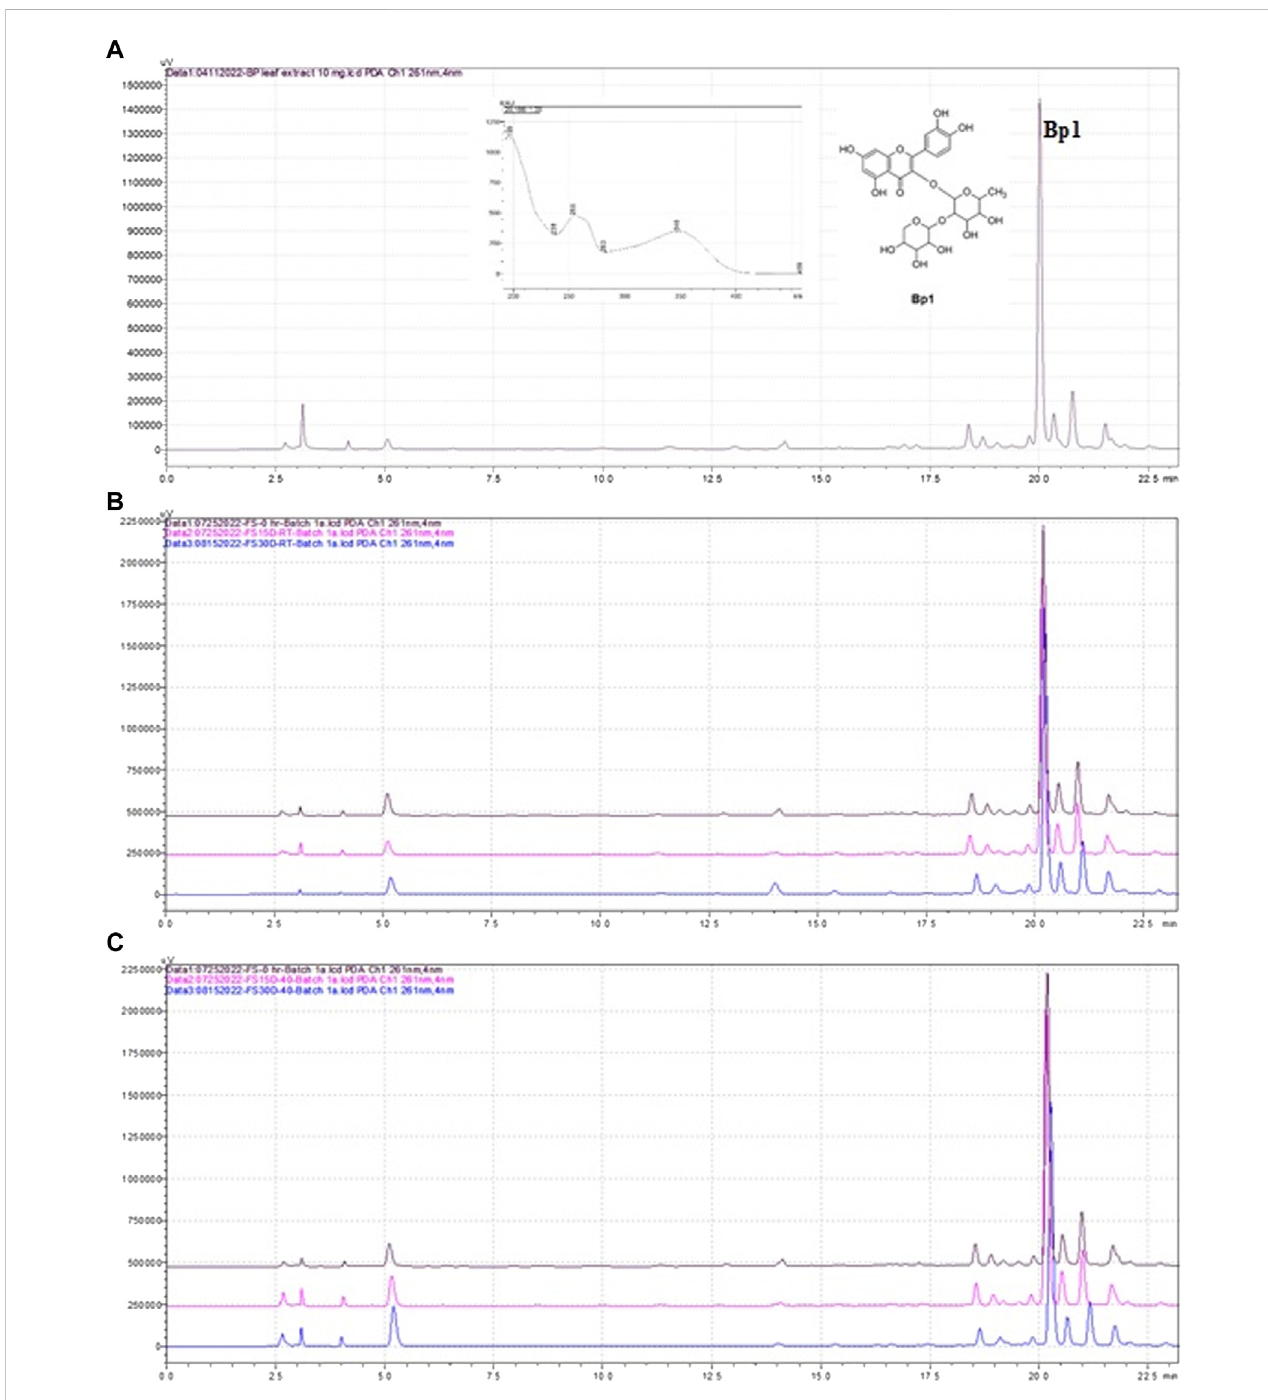
FIGURE 2 Chromatographic pro fi le obtained by HPLC-DAD of B. pinnatum leaf extract (A) , solution extracted from gel 1 at room temperature (22 ° C – 25 ° C) at different endpoints (0, black line, 15 days, pink line, and 30 days, blue line) (B) and the solution extracted from gel 1 at 40 ° C/75% HR at different endpoints (0, black line, 15 days, pink line, and 30 days, blue line) (C) Stationary phase: Phenomenex Luna C18 (150 × 4.6 mm, 2.6 mm) equipped with a Phenomenex Luna C18 guard column (10 mm × 2.1 mm, 5 μ m). Mobile phase: A (0.1% formic acid in water) and B (acetonitrile); 10% of B for 5 min, gradient until 55% B at 35 min, to 95% B at 37 min, maintained for 2 more min at 95%, and a subsequent re-equilibration period of 6 min 10% B; fl ow elution 1 ml/min; detection 261